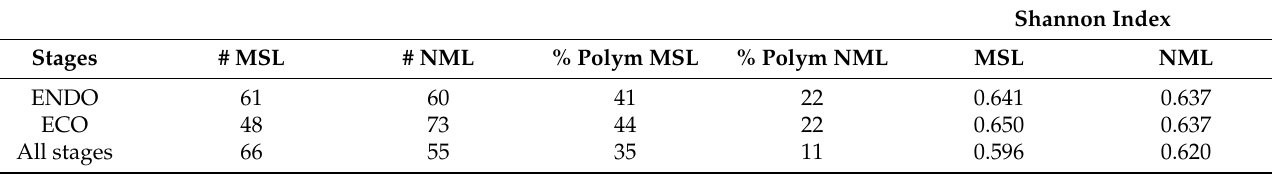
Table 4. Analysis of genetic (NML) and epigenetic diversity (MSL) of ‘Royal Dawn’, ‘Red Glen’ and ‘Kordia’ varieties, considering endodormancy (ENDO) and ecodormancy (ECO) stages. # MSL and # NML represent, respectively, the number of methylation-sensitive loci and non-methylated